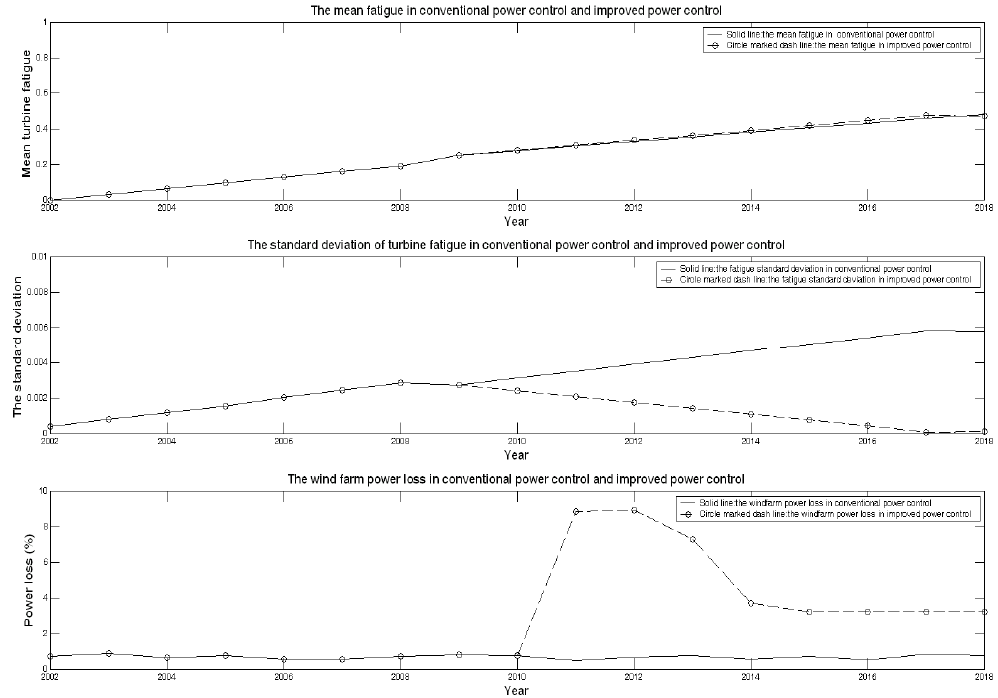
Figure 11. Performance of the conventional and improved control in the Horns Rev OWF.